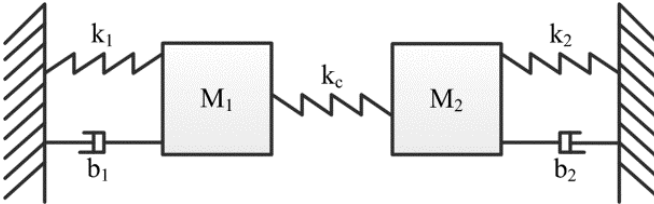
Figure 2. The mass-stiffness-damper model of coupled resonators. The frequency shift of strongly coupled resonators has been deduced in reference [125].